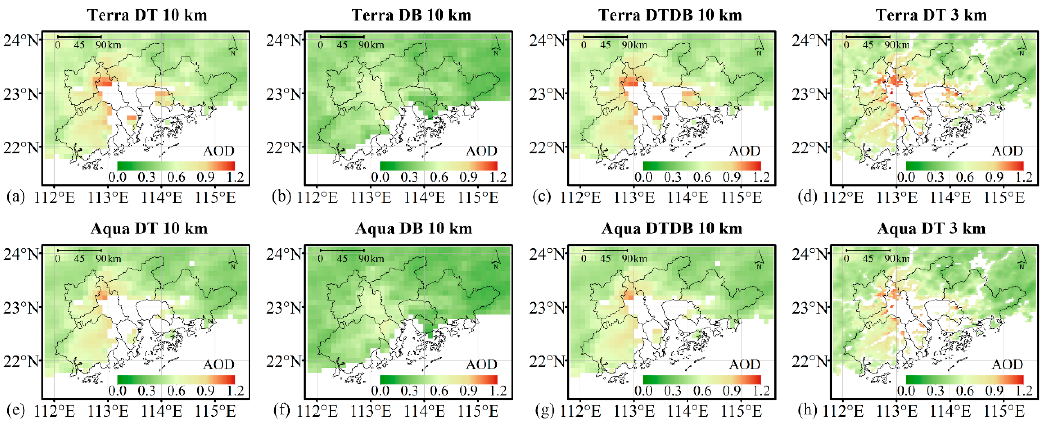
Figure 5. Ten-year (2006–2015) mean AOD for Terra ( a – d ) and Aqua ( e – h ) MODIS aerosol products.